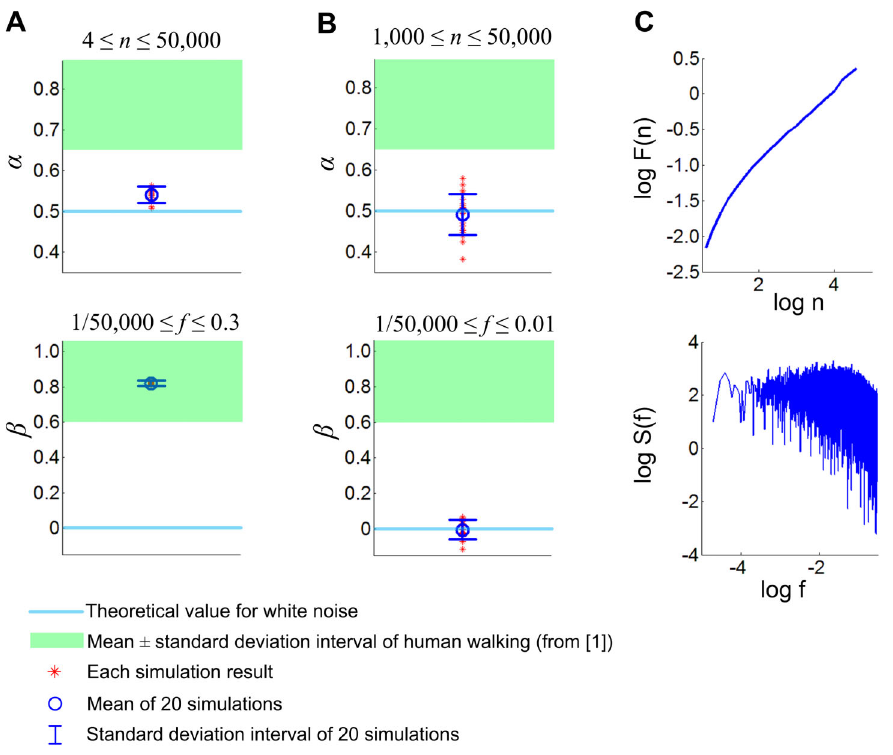
Figure 8. Scaling exponents a and b for 100,000 stride walking with h 0 = p /12. The scaling exponents are significantly different from those of the uncorrelated noise, but the evidence of long-range correlations is less prominent. In A, a is close to that of white noise though b is similar to that of human walking with long-range correlations. In B, the exponents are evaluated with window sizes larger than 1,000 strides (1,000 # n # 100,000/2, and 2/100,000 # f # 0.01); the exponents are not significantly different from those of white noise. C shows the representative data. On the whole, the local slope of the curve relating log F ( n ) and log n decreases as window size n increases.